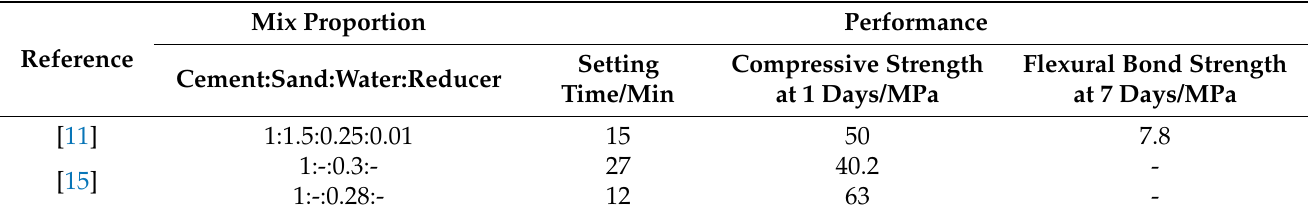
Table 5. Properties of Sulphoaluminate cement mortar as repair